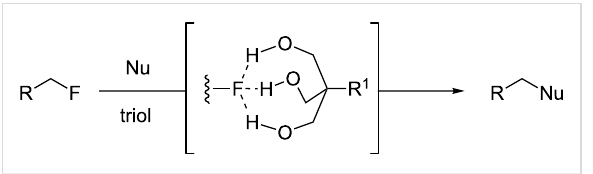
Figure 2: Proposed activation of C–F bonds mediated by a